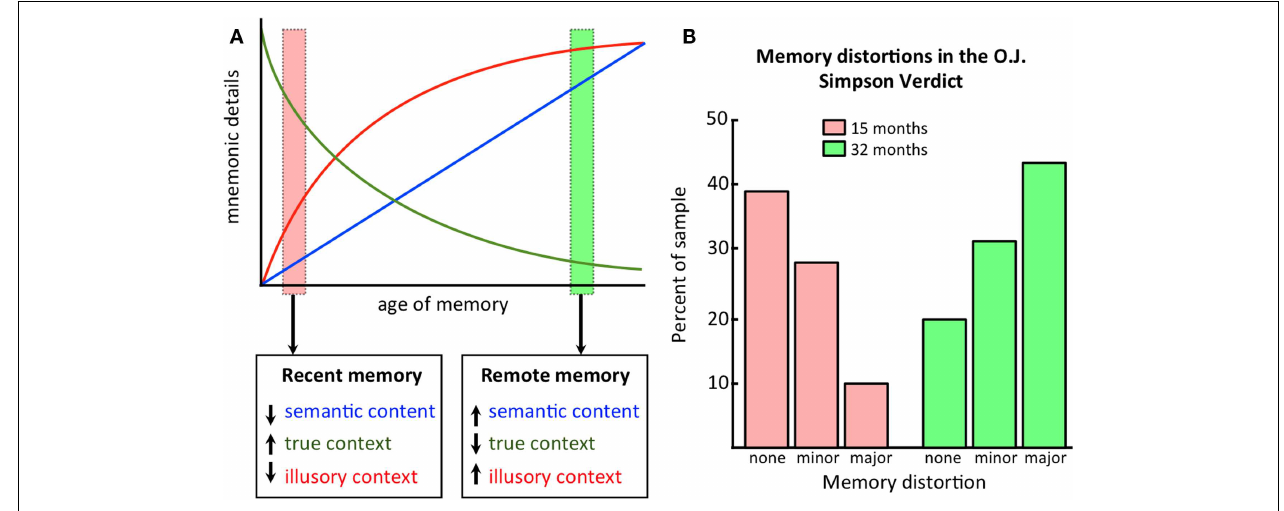
while true contextual details are replaced by illusory details; (B) An empirical demonstration of how illusory details increase as a function of time. See text for discussion. Data plotted based on values from Schmolck et al.